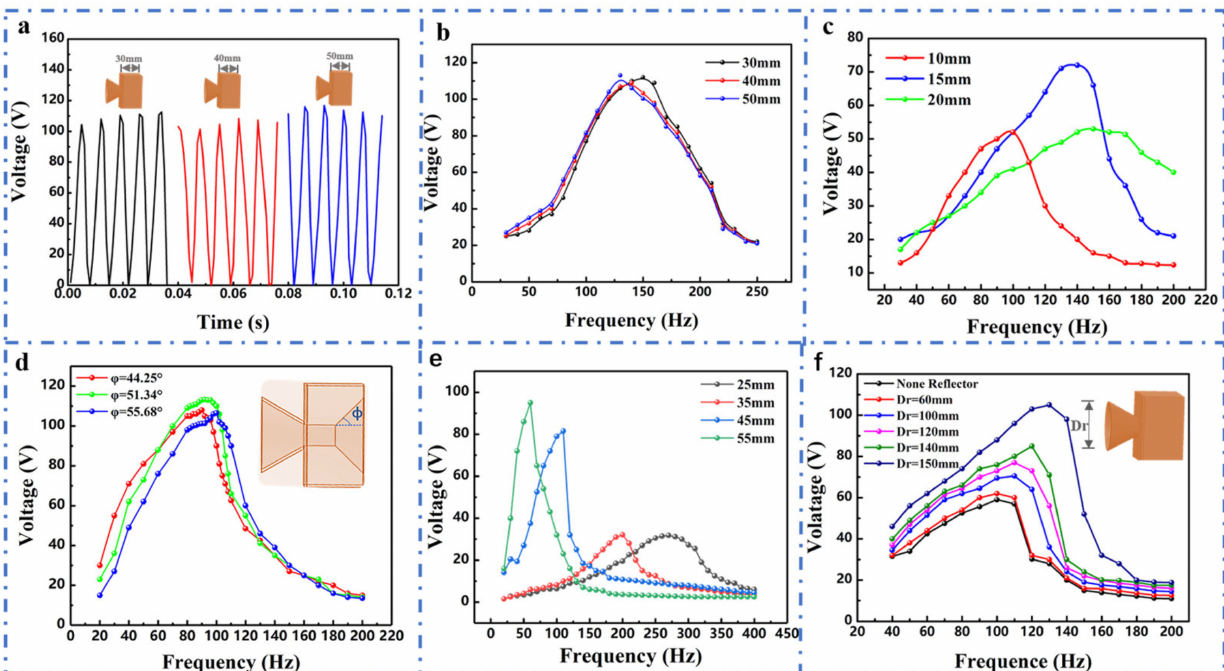
Figure 4. Electric output characterization of the CHR-TENG with varied geometrical sizes. ( a ) The maximum peak open-circuit voltage output of the CHR-TENG with different resonator thicknesses. ( b ) Open-circuit voltage output of the CHR-TENG with different resonator thicknesses. ( c ) Open-circuit voltage output of the CHR-TENG with different cross-sectional areas. ( d ) Open-circuit voltage output of the CHR-TENG with different coniform angles. ( e ) Open-circuit voltage output of the CHR-TENG with varied FEP film sizes. ( f ) Open-circuit voltage output of the CHR-TENG with different reflector